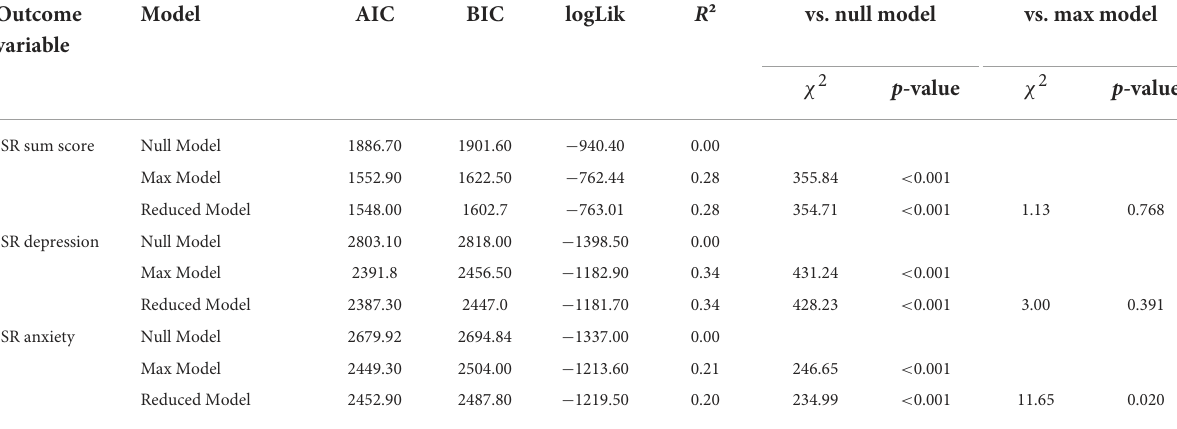
TABLE 3 Model comparisons of linear-mixed effect models predicting ISR